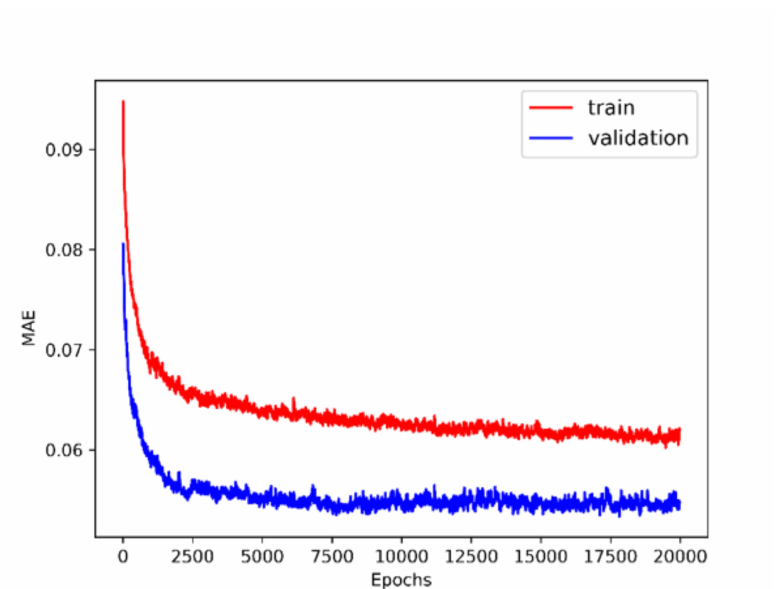
Figure 15. Five-fold cross validation results (FSI